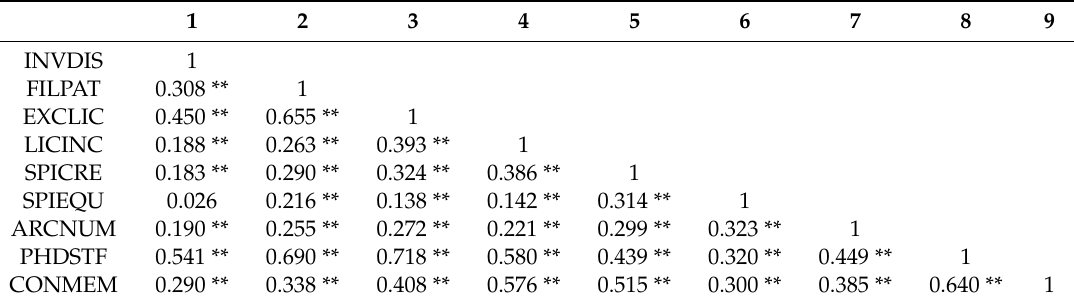
Table 5. Pearson’s correlation co-e ffi